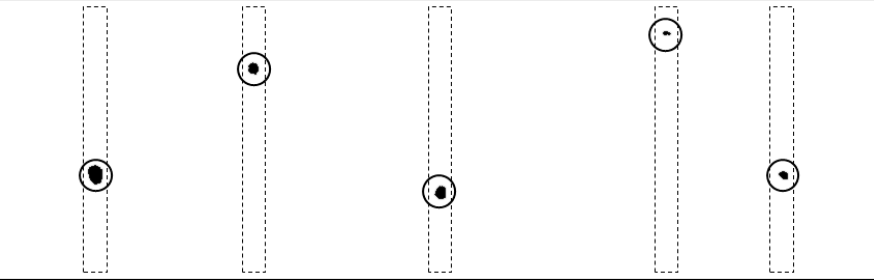
Figure 3. Original image of the flap tips after binarization and color inversion for a single instant in the process of self-organization. For reference, we overlaid circles marking the centers of the centroids and the flap tip contours (dashed lines). The oscillatory motion is along the horizontal image axis, perpendicular to the flap span. The left-most flap is i = 1, and the right most is i = 5 in rising order. Note that the roots of the model cilia are uniformly spaced, as shown in Figure 1. The image shown here is what is seen by the camera as the tips of the cilia while they are in motion. Thus, the tip contours are not uniformly spaced in the image.